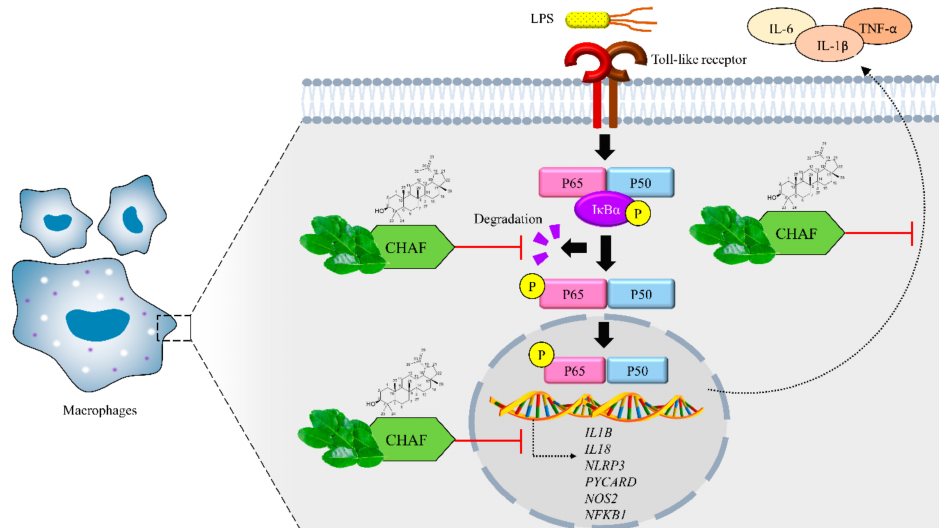
Figure 7. Anti-inflammatory and anti-inflammasome mechanisms of CHAF. Binding of LPS to Toll-like receptor resulting in I κ B- α phosphorylation and degradation. The active form of NF- κ B translocates into the nucleus and induces the transcription of pro-inflammatory and inflammasome-associated genes as well as release of cytokines such as IL-1 β , IL-6 and TNF- α . CHAF attenuates the inflammation process by suppressing I κ B- α phosphorylation and NF- κ B p65 subunit expression. This inhibition leads to down-regulating inflammatory-associated gene expressions and decreasing the release of pro-inflammatory